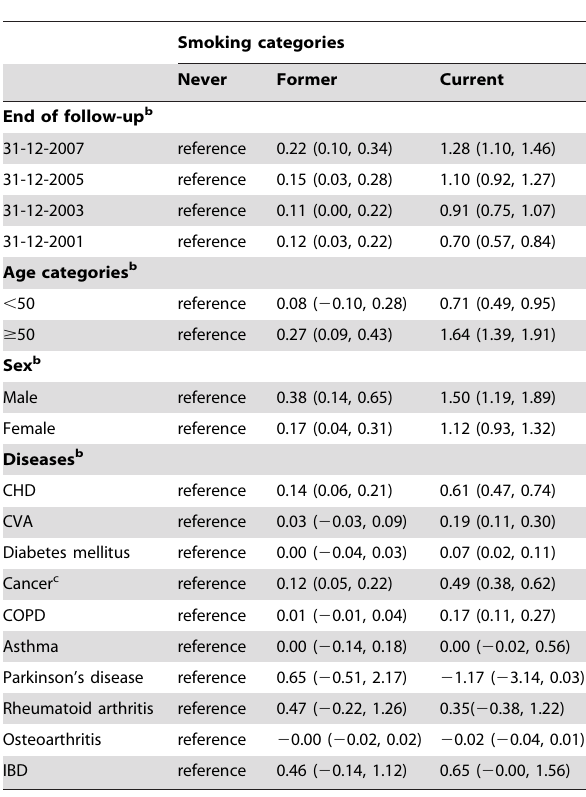
Abbreviations: CHD, Coronary Heart Disease; CVA, Cerebrovascular Accident; COPD, Chronic. Obstructive Pulmonary Disease; IBD, Inflammatory Bowel Disease. a DALYs in this table are calculated using life expectancy calculated at time of death or if alive at end of follow-up (method 4). b Models adjusted for age, sex and BMI, physical activity, education, ethanol and energy intake. c DALYs have been calculated for each specific cancer type but were aggregated for this